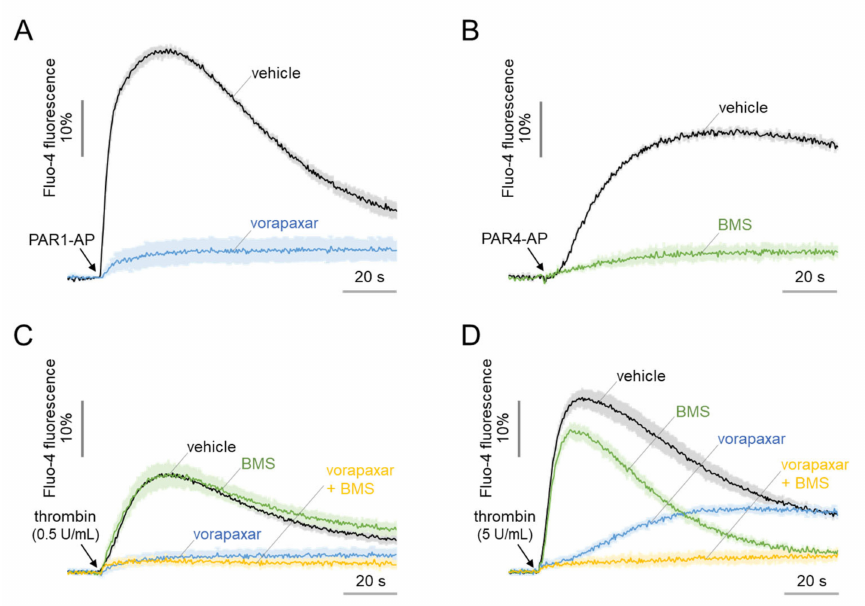
Figure 2. Intracellular calcium increase in response to the activation of PAR1 and PAR4 in MEG-01 cells. Intracellular calcium increase in MEG-01 cells induced by ( A ) PAR1-AP (100 µ M), ( B ) PAR4-AP (100 µ M), ( C ) low-dose thrombin (0.5 U/mL), and ( D ) high-dose thrombin (5 U/mL). PAR1 and PAR4 were completely blocked by vorapaxar and BMS-986120 (BMS), respectively. Vorapaxar and BMS were applied at 10 µ M for 10 min prior to treatment of PAR1-AP, PAR4-AP and thrombin (mean ± S.D., n = 3–5).